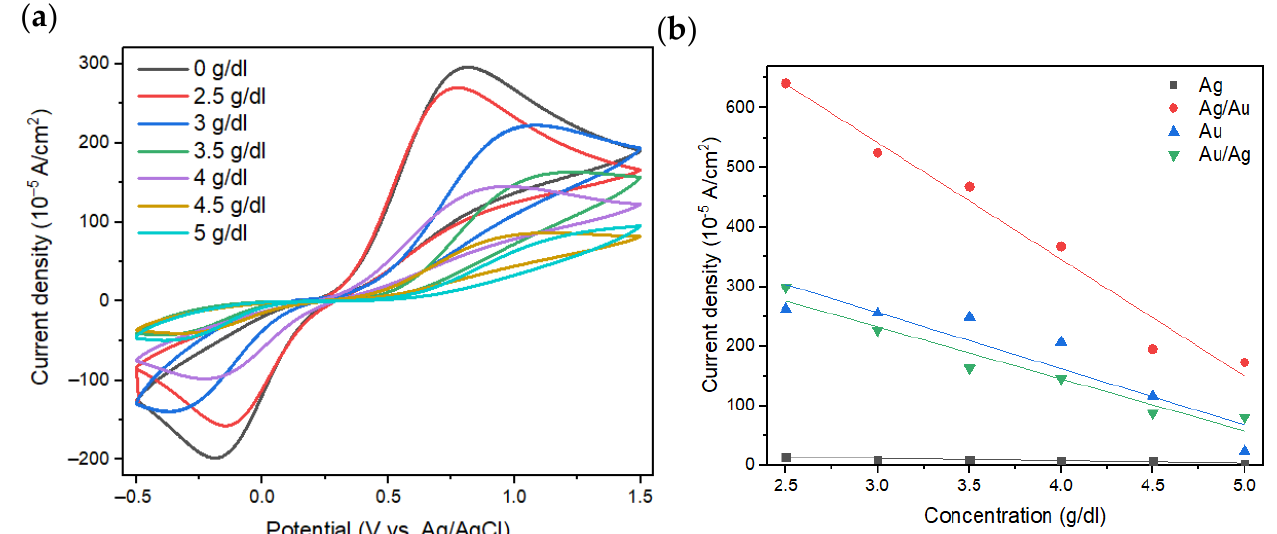
Figure 6. ( a ) The results of the CV tests with varying BSA concentrations on the Au/Ag thin film. ( b ) oxidation peaks of the Ag, Ag/Au, Au, and Au/Ag thin film electrodes with varying BSA concen- trations.